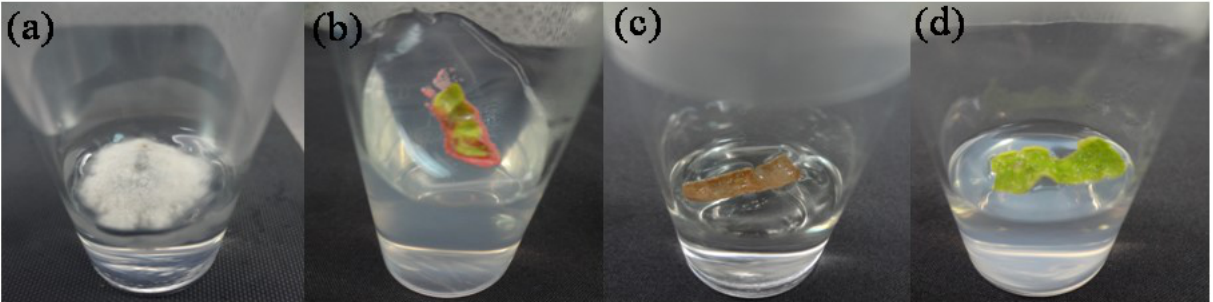
Figure 1. Effect of surface sterilization on explants of stevia by different concentrations of Clorox (0, 5, 10, 15, 20, and 30%) for different periods of time (5, 10, 15, and 20 min): ( a ) explant with fungal contamination; ( b ) explant with bacterial contamination; ( c ) non-contaminated explant; and ( d ) survived explant.